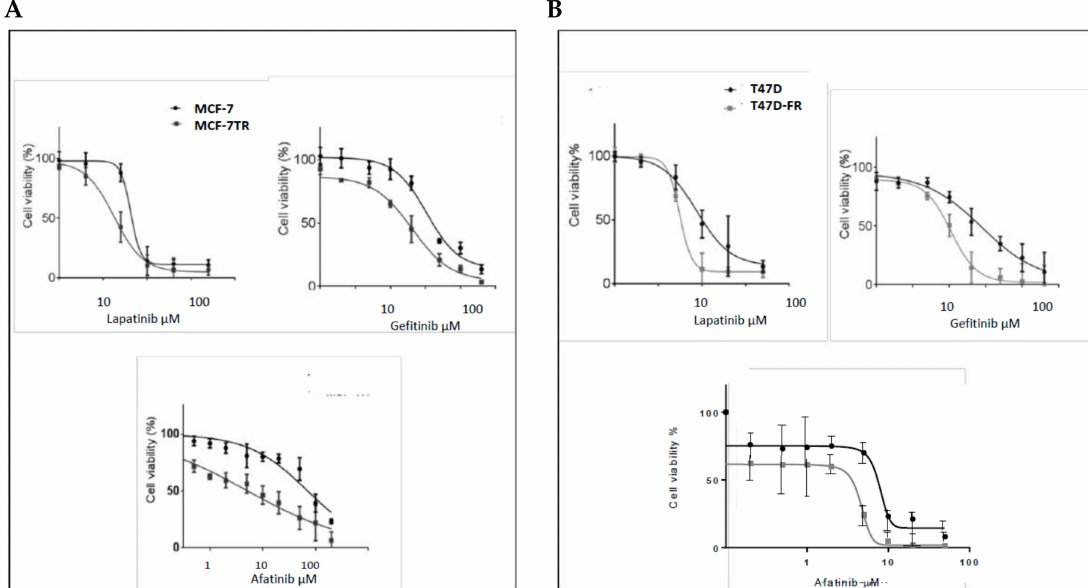
Figure 3. Sensitivity of breast cancer cell lines with acquired resistance to anti-oestrogen therapy to tyrosine kinase inhibitors (TKIs), assessed by MTT assay ( n ≥ 4), ( A ) MCF-7 and ( B ) T47D cell lines. Dose–response curves were fitted using the Prism (version 6) program. Data show a broad collateral sensitivity of anti-endocrine-resistant cells to lapatinib, gefitinib, and afatinib. See Section 2.3 for statistical